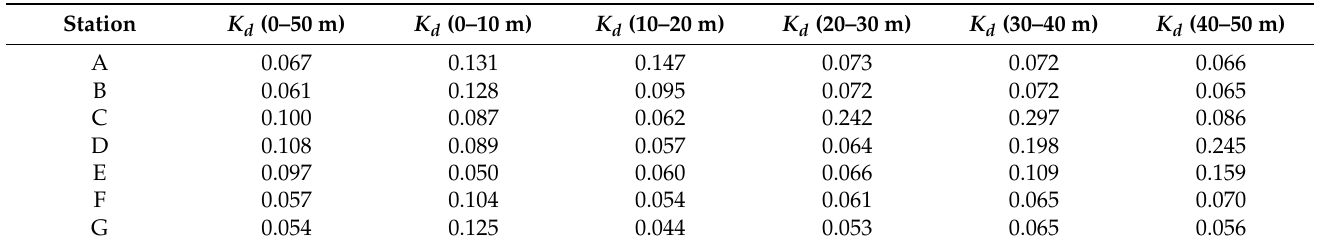
Table 4. The diffuse PAR attenuation coefficient K d at different depths, as well as the integral coefficient for a layer of 50